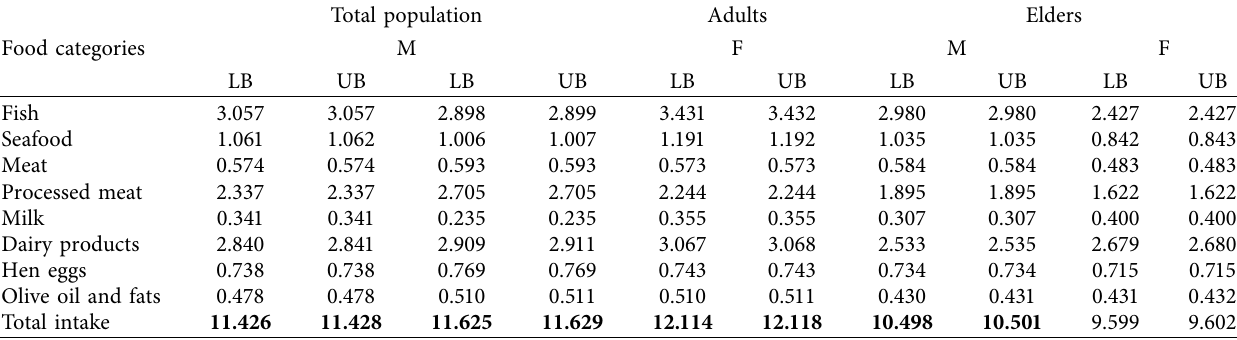
Table 3: Estimated daily intakes of iPCBs (ngkg − 1 bwd − 1 ) from the consumption of various categories of food for the total population and for adults (18–64.9 years) and elders ( ≥ 65 years).